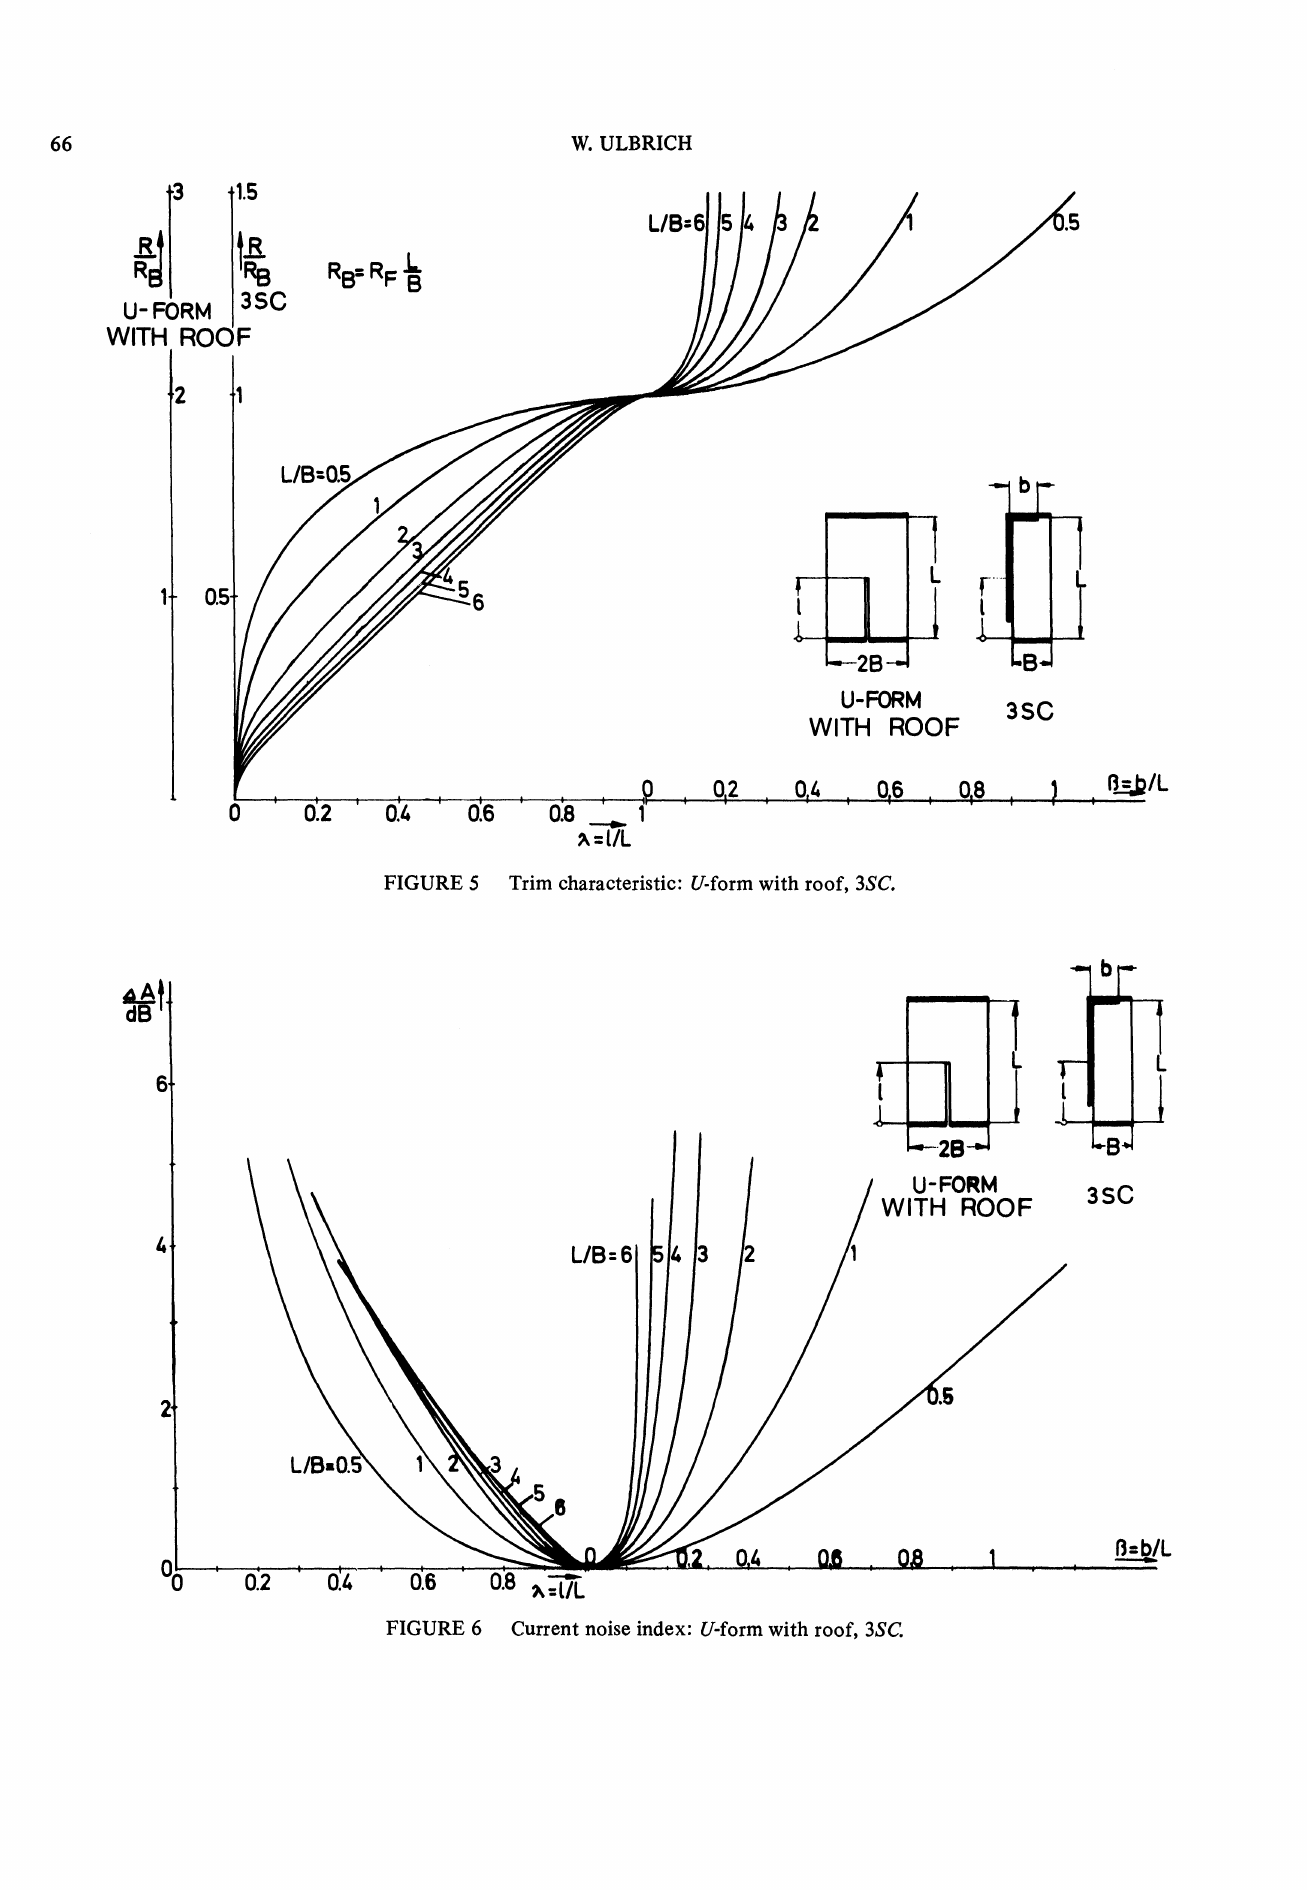
FIGURE 6 Current noise index: U-form with roof,